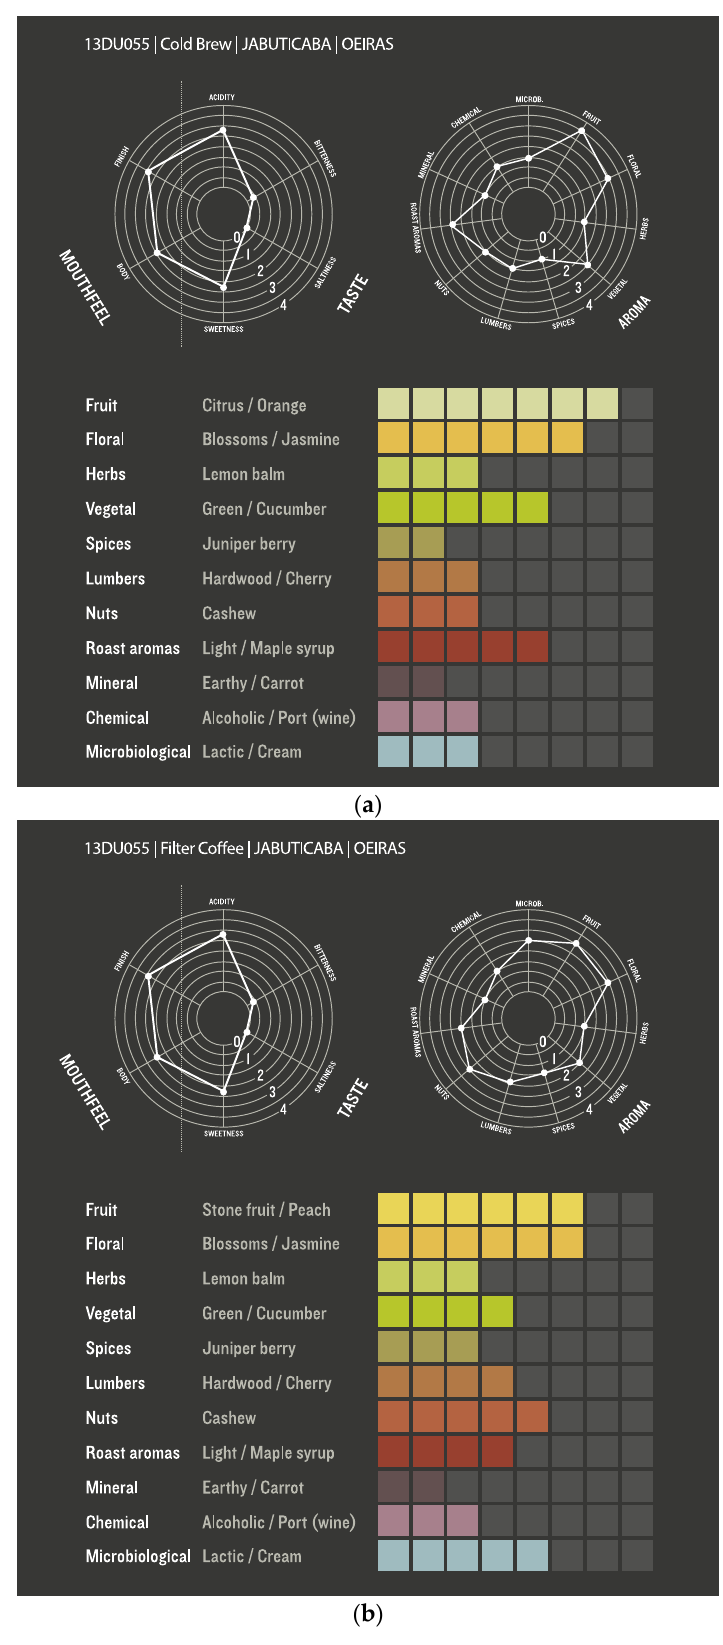
Figure 6. Flavor profiles of a cold brew ( a ) compared with a filter coffee ( b ) of the same coffee.